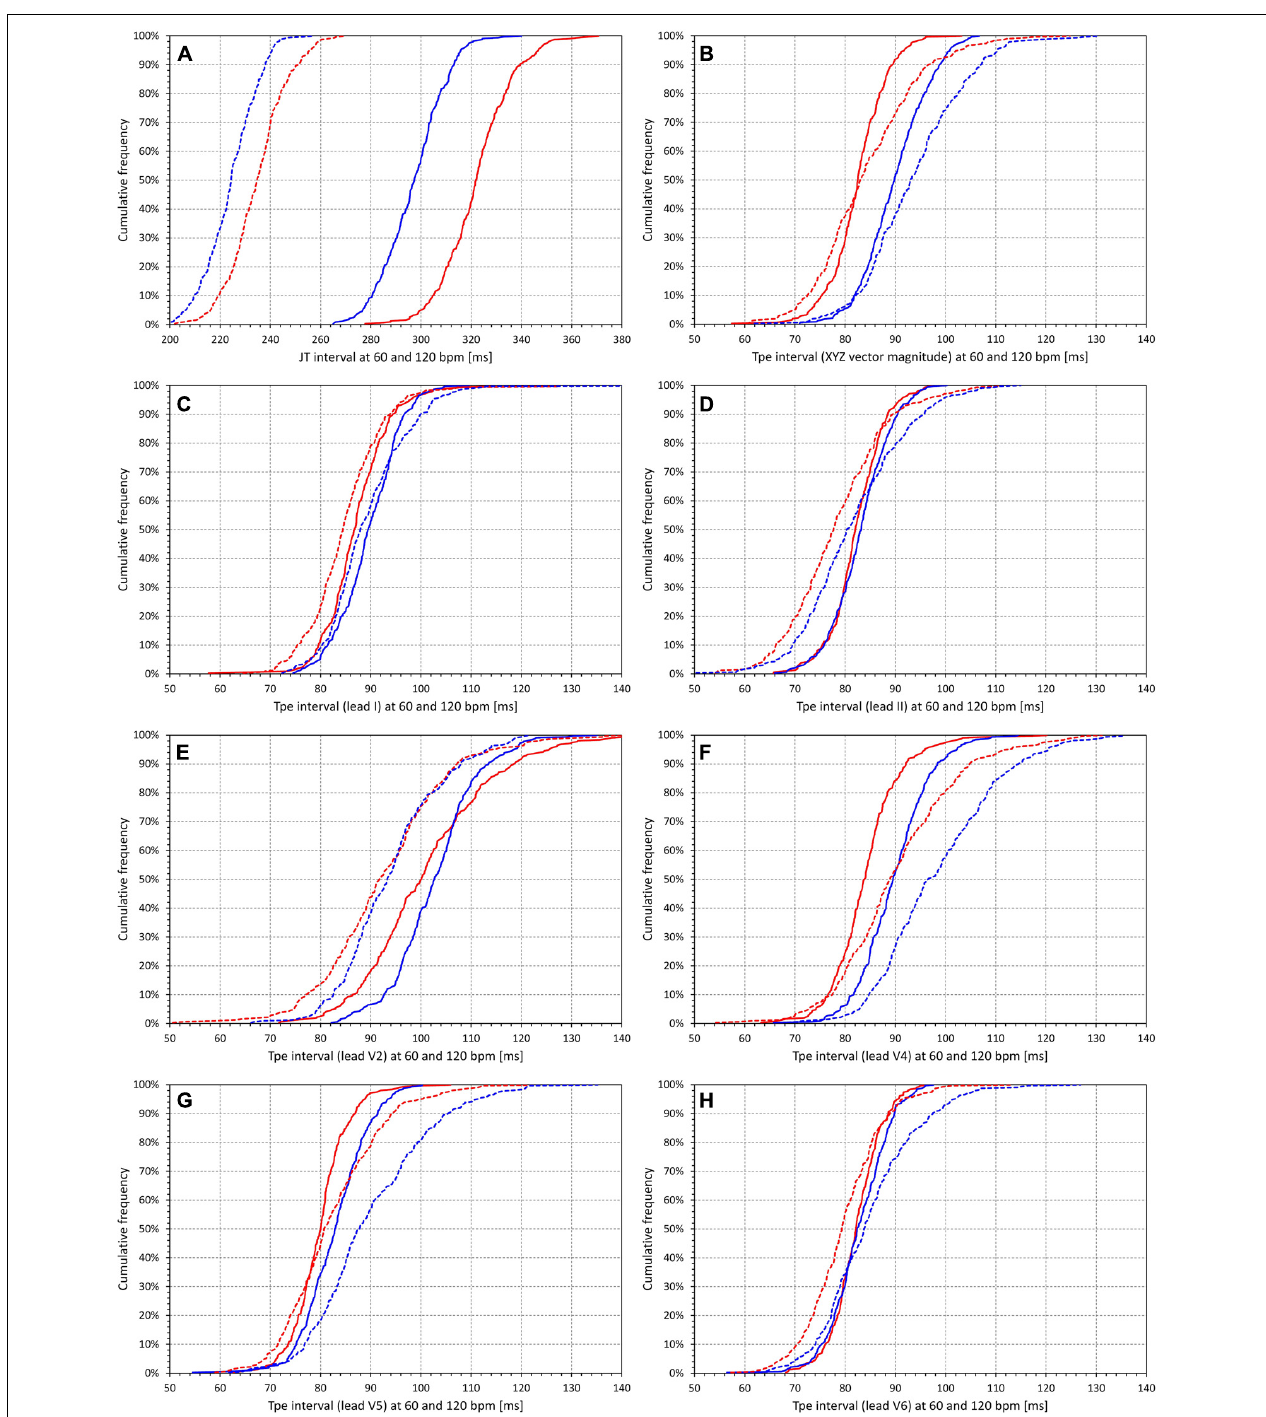
FIGURE 6 | Cumulative distributions of intrasubject regression projections of the (A) JT intervals and (B–H) Tpe intervals corresponding to heart rate of 60 beats per minute (bpm) (solid lines) and to heart rate of 120 bpm (dashed lines). (B–H) correspond to different electrocardiogram (ECG) leads in the same way as the panels of Figure 5 . In each panel, the red and blue lines correspond to the distributions in female and male subjects, respectively. Note that while in (A) , the horizontal axis ranges between 200 and 380 ms, the horizontal axes in all other panels range between 50 and 140 ms.